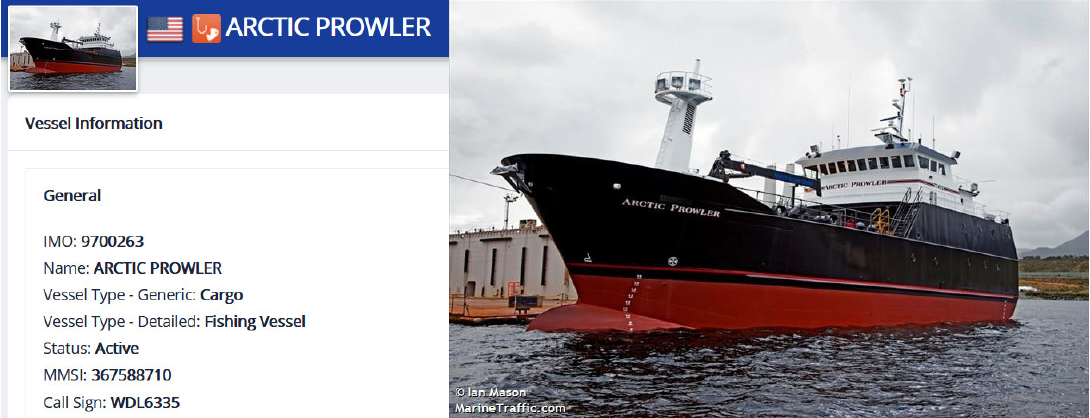
Longitude Figure 6. The historical trajectory of the ship (MMSI: 367588710). The Marine Traffic website [41] is one of the most popular online ship tracking ser- vice websites in the world. It can provide a real-time chart of global maritime routes